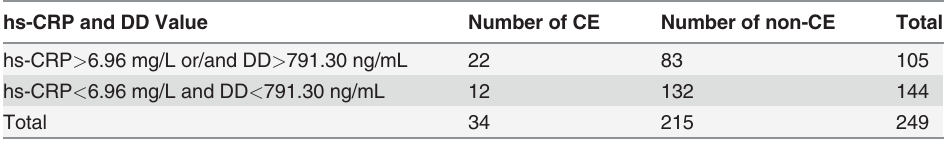
Table 3. Evaluation of hs-CRP and DD in combined diagnosis of CE (parallel diagnostic tests). hs-CRP and DD Value Number of CE